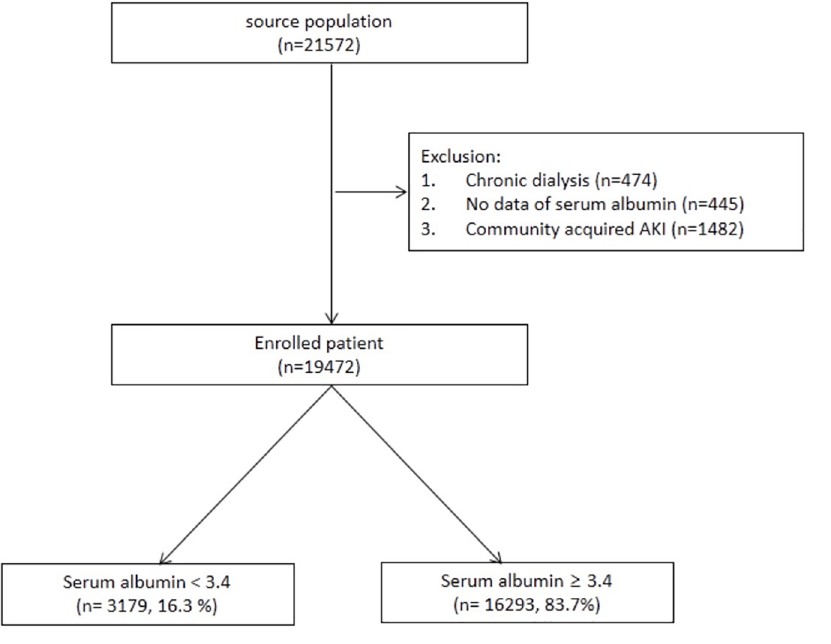
Fig 1. Selection